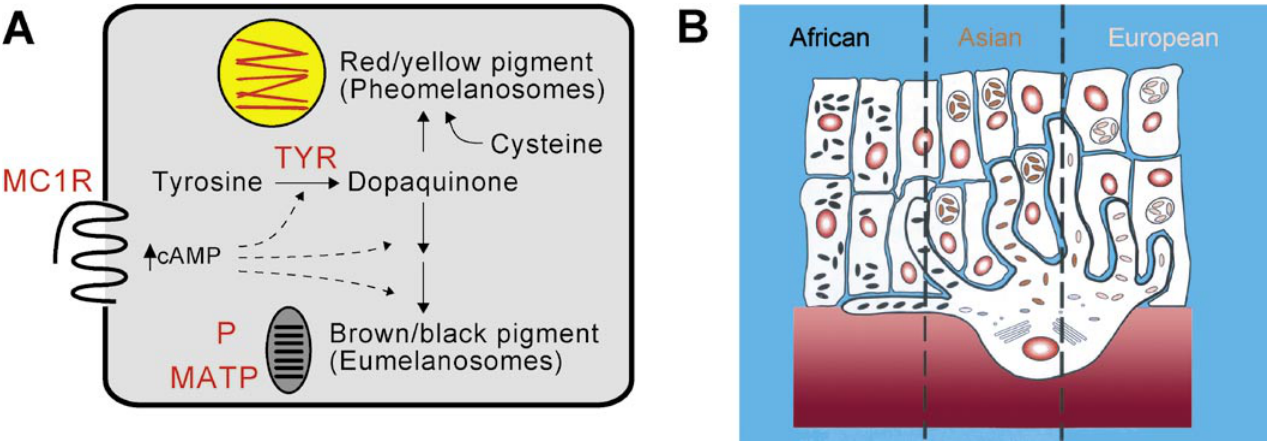
Figure 1. Biochemistry and Histology of Different Skin Types (A) Activation of the melanocortin 1 receptor (MC1R) promotes the synthesis of eumelanin at the expense of pheomelanin, although oxidation of tyrosine by tyrosinase (TYR) is required for synthesis of both pigment types. The membrane-associated transport protein (MATP) and the pink-eyed dilution protein (P) are melanosomal membrane components that contribute to the extent of pigment synthesis within melanosomes. (B) There is a gradient of melanosome size and number in dark, intermediate, and light skin; in addition, melanosomes of dark skin are more widely dispersed. This diagram is based on one published by Sturm et al. (1998) and summarizes data from Szabo et al. (1969), Toda et al. (1972), and Konrad and Wolff (1973) based on individuals whose recent ancestors were from Africa, Asia, or